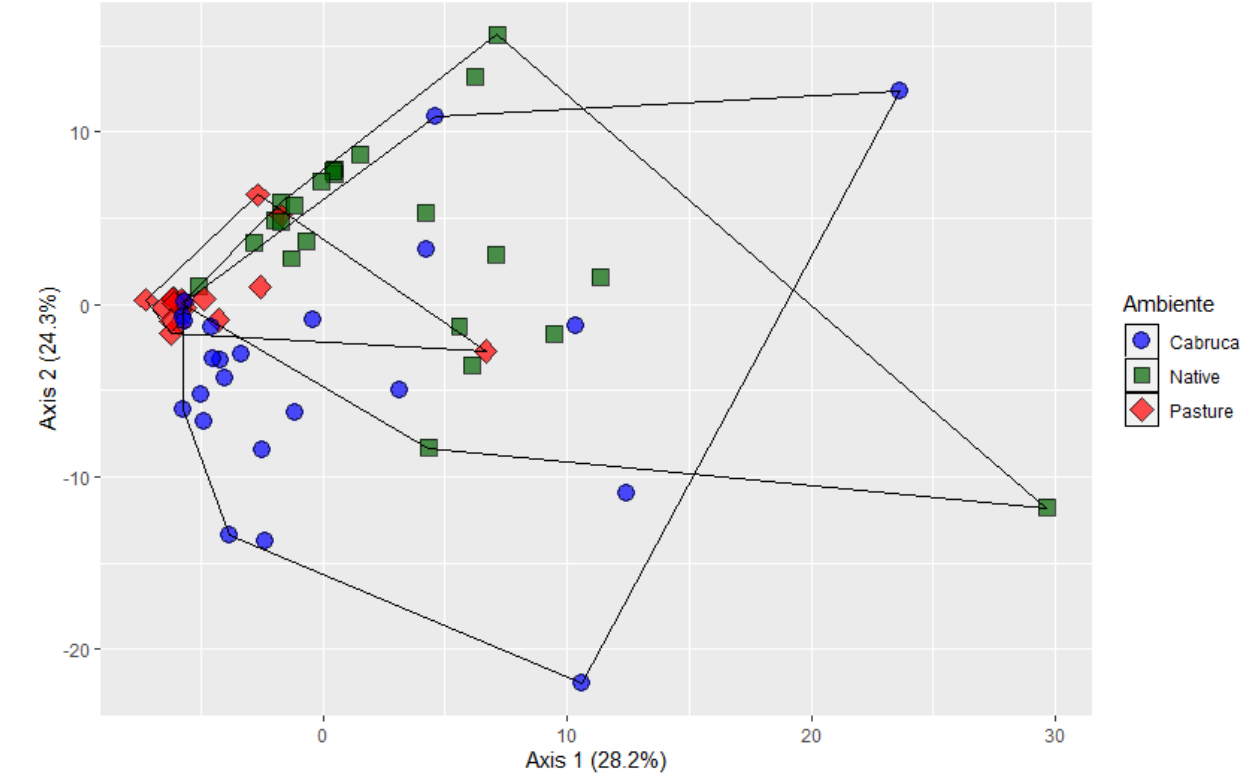
Figure 3. PcoA chart demonstrating the similarity of the composition of Odonata assemblages among the land uses: native forest, cabruca, and pasture areas. The dots in green or with the letter N are associated with areas of native vegetation, dots in blue or with the letter C are associated with areas of cacao cultivation, and dots in red or with the letter P are associated with pasture areas. Table 1. Indicator species for the different land uses (cabruca, native forest and pasture) based on the IndVal